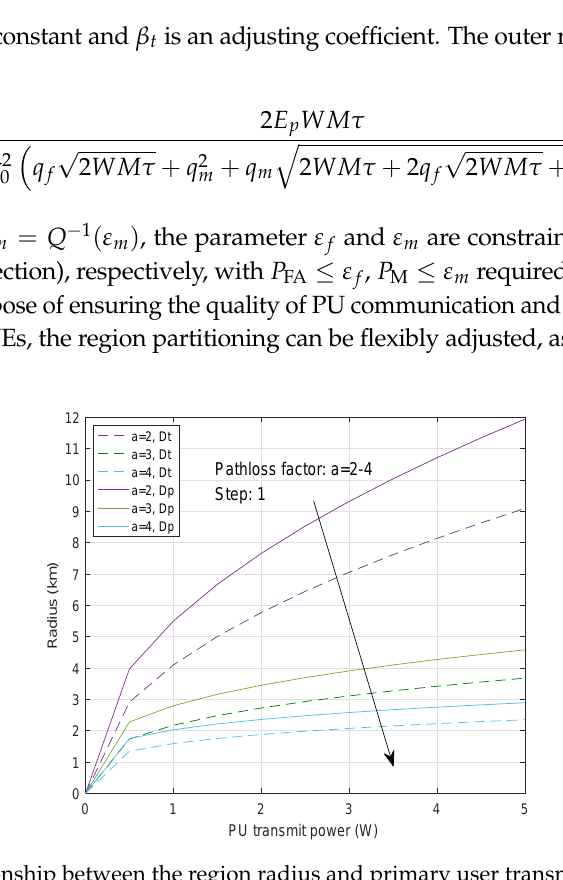
Figure 2. Relationship between the region radius and primary user transmitter (PUT)